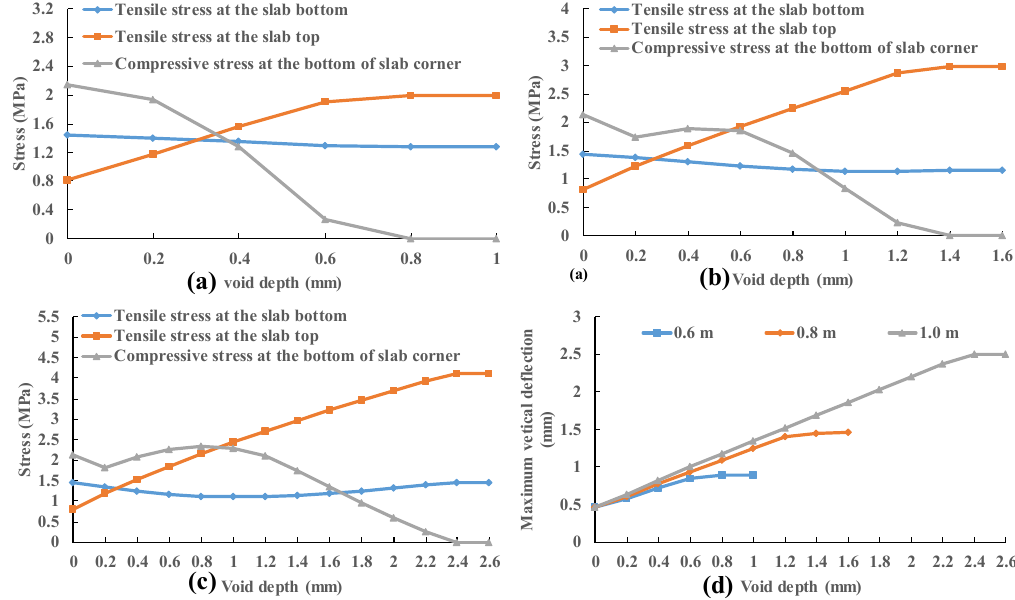
Figure 14. Stress variation of 24 cm thick slab with void depth: ( a ) void size is 0.6 m; ( b ) void size is 0.8 m; ( c ) void size is 1.0 m and ( d ) vertical deflection.